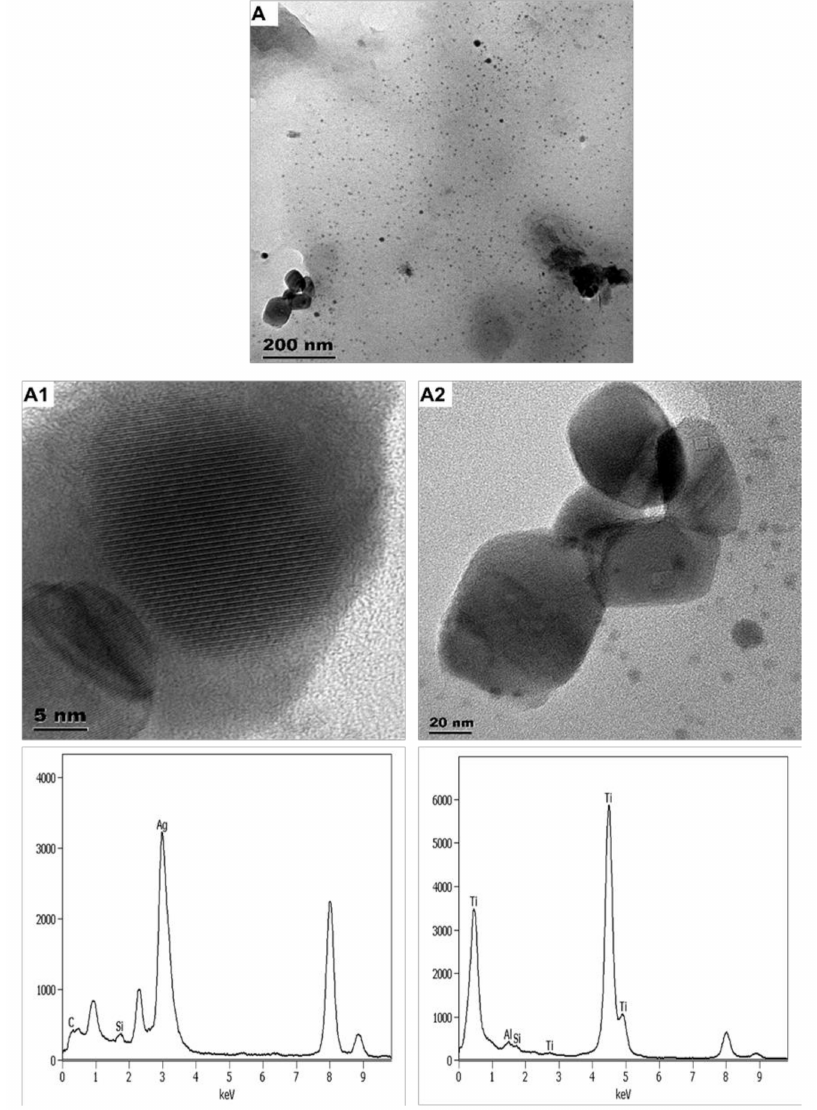
Figure 4. Images and respective spectra obtained from TEM-EDX characterisation of SK1-released ENMs ( A ). Images ( A1 , A2 ) are high magnification of image A, specifically showing near-spherical SK1-released nAg and angular SK1-released nTiO 2 particles,